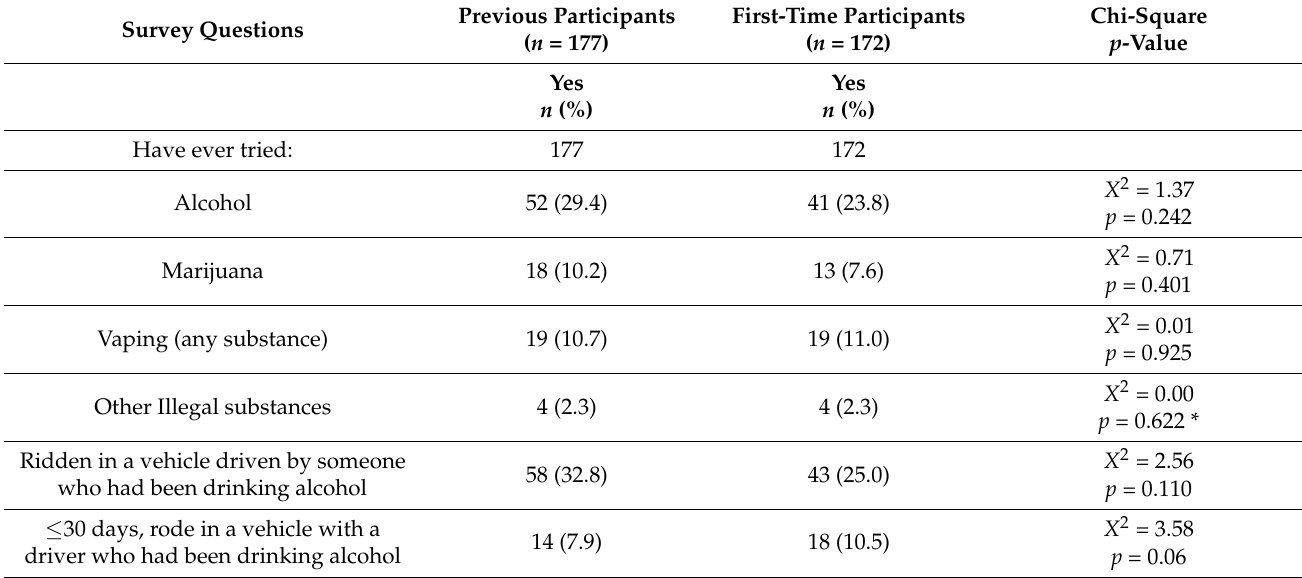
Table 2. Baseline Behavioral Responses ( n = 349).